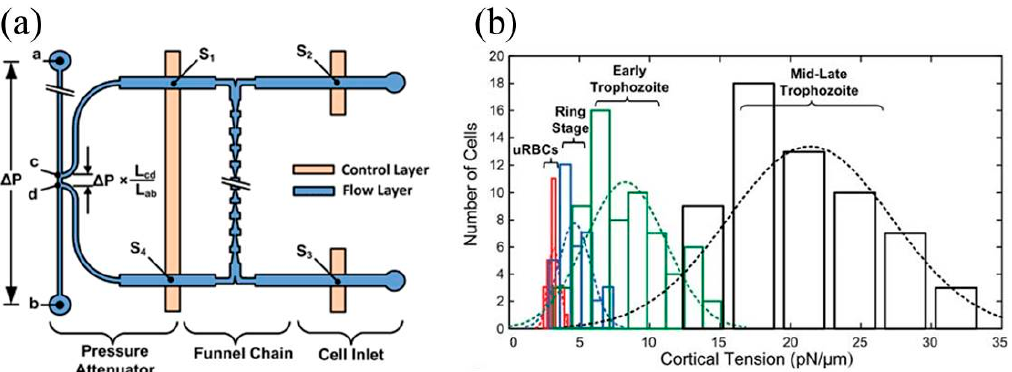
Figure 3. ( a ) Design of the flow and control layers of the microfluidic constriction channel capable of generating precisely controlled pressure to quantify the critical threshold requested to push each RBC through the constriction channel. In this study, the pressure regulator divides an externally applied pressure by a factor of 100, which is further applied across the funnel chain; ( b ) Histogram of the quantified cortical tensions of RBCs in various stages. Reproduced with permission from [30].